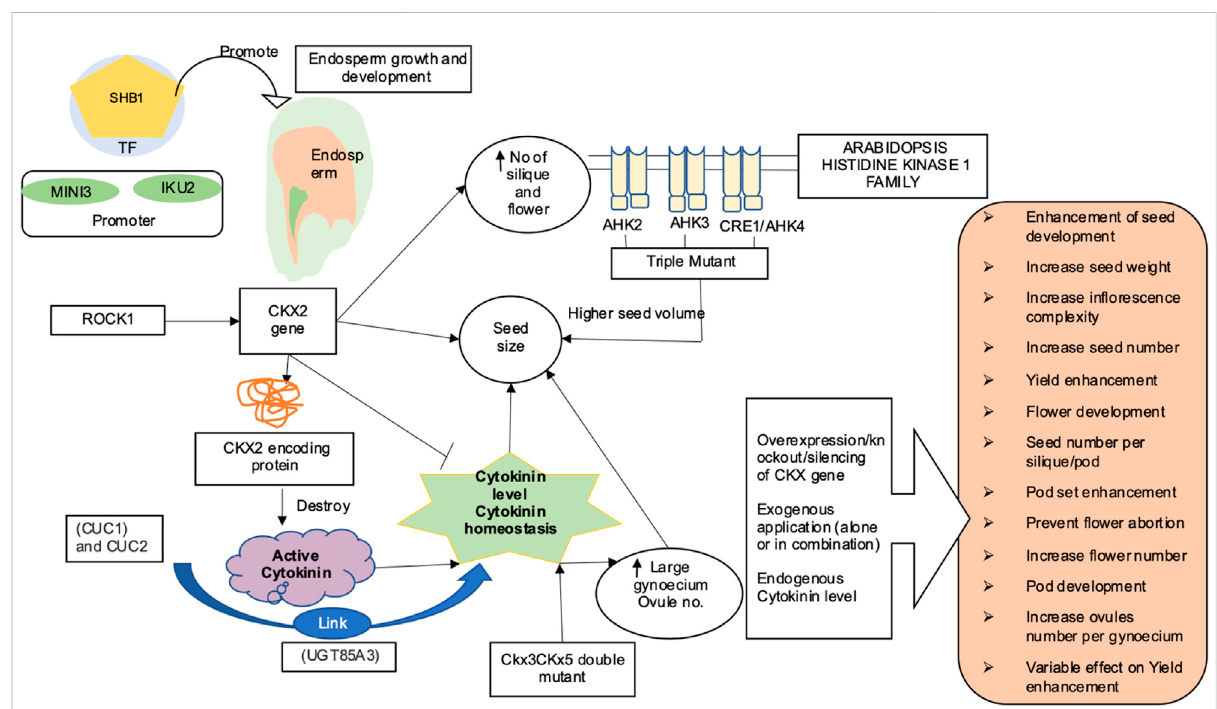
FIGURE 2 Cytokinin-mediatedregulationofyieldandyield-relatedtraits(SHB1,ShortHypocotylUnderBlue1;ROCK1,Repressorofcytokininde fi ciency1; AHK1, Arabidopsis histidine kinase1 family; CKX2 , Cytokinin oxidase/dehydrogenase; CUC , Cup-shaped cotyledon; MINI3 , MINISEED 3 ; IKU2 , HAIKU2 ) (Rie fl er et al., 2006; Zhou et al., 2009; Li et al., 2013). Various strategies such as overexpression of gene CKX/IPT (Werner et al., 2003), knockdown of CKX gene family (Ashikari et al., 2005), gene silencing (Heyl et al., 2008; Schoor et al., 2011), and exogenous application of CK (Nagel etal., 2001; Liu etal., 2018; Talukdar et al., 2022)have been attempted to enhance yield-related trait in pulses and oilseed crop. Dynamic role of cytokinin in orange box-in Arabidopsis;CKs are involved information of more number of fl ower,silique, seed (Bartrina et al., 2011; Niemann et al., 2015), ovule number, and seed yield (Werner et al., 2003; Cucinotta et al., 2018; Nguyen et al., 2021b; Zu et al., 2022) In soybean, CKs are involved in preventing fl ower abortion and in pod setting (Nonokawa et al., 2012), associated with seed development and fatty acid biosynthesis (Nguyen et al., 2016),increaseseedyield(Kambhampatietal.,2017),podsetandseed fi lling(JamesonandSong2016;Kambhampatietal.,2017;Caietal.,2018;Liu etal., 2018),and reduction in fl oral abscission and increase podnumber and seed weight (Carlson et al.,1986; Nagelet al., 2001)In Brassica increase in seed number per ovule number, pod number, seed weight (Zuniga-Mayo et al., 2018; Schwarz et al., 2020), more pod number, and increase in seed yield was observed (Atkins et al.,